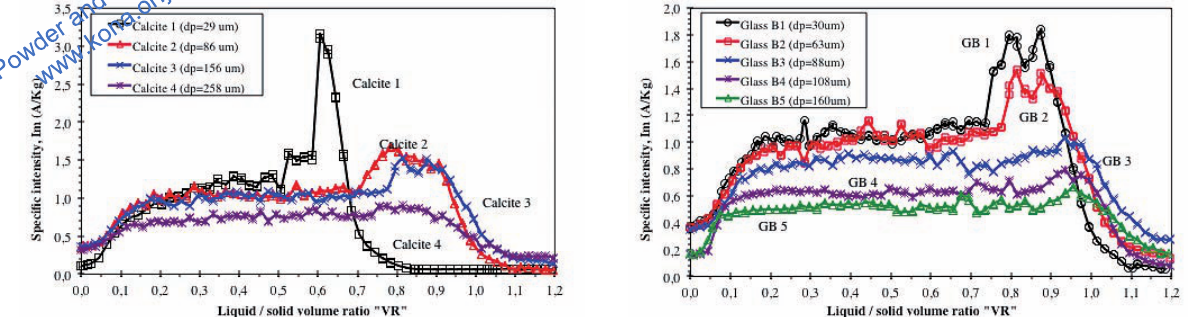
Fig. 1b Intensity consumption of the calcite (left) or glass beads (right) mixed with a progressive water addition (40 ml/ min; 120 rpm) in a planetary mixer